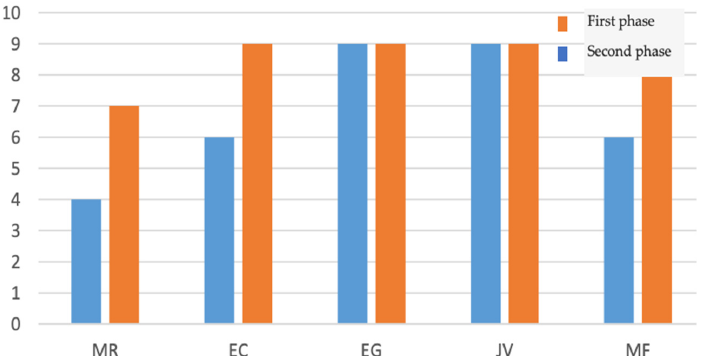
Figure 1. Results of the knowledge acquired after the teachings conducted during hospitalization (six answers). Table 3. Degree of dyspnea, during hospitalization and 15 days after discharge.